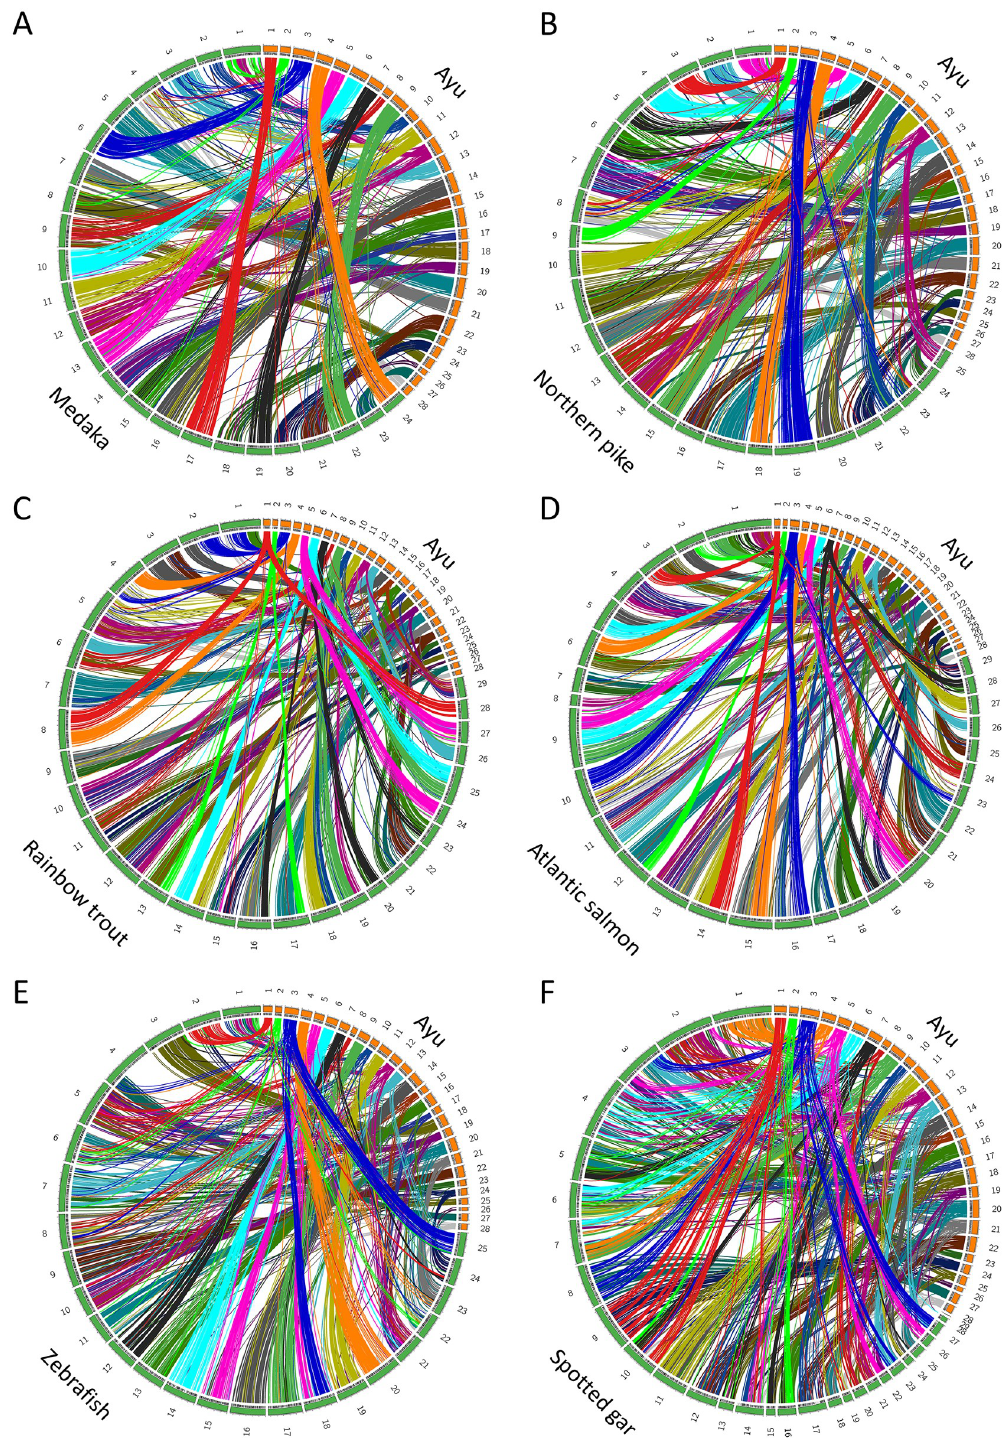
Fig 1. Synteny analysis between ayu genome and those of other teleost fishes. Circos plots between genomes of ayu and (A) medaka, (B) northern pike, (C) rainbow trout, (D) Atlantic salmon, (E) zebrafish and (F) spotted gar. Colored lines link pairs of orthologous